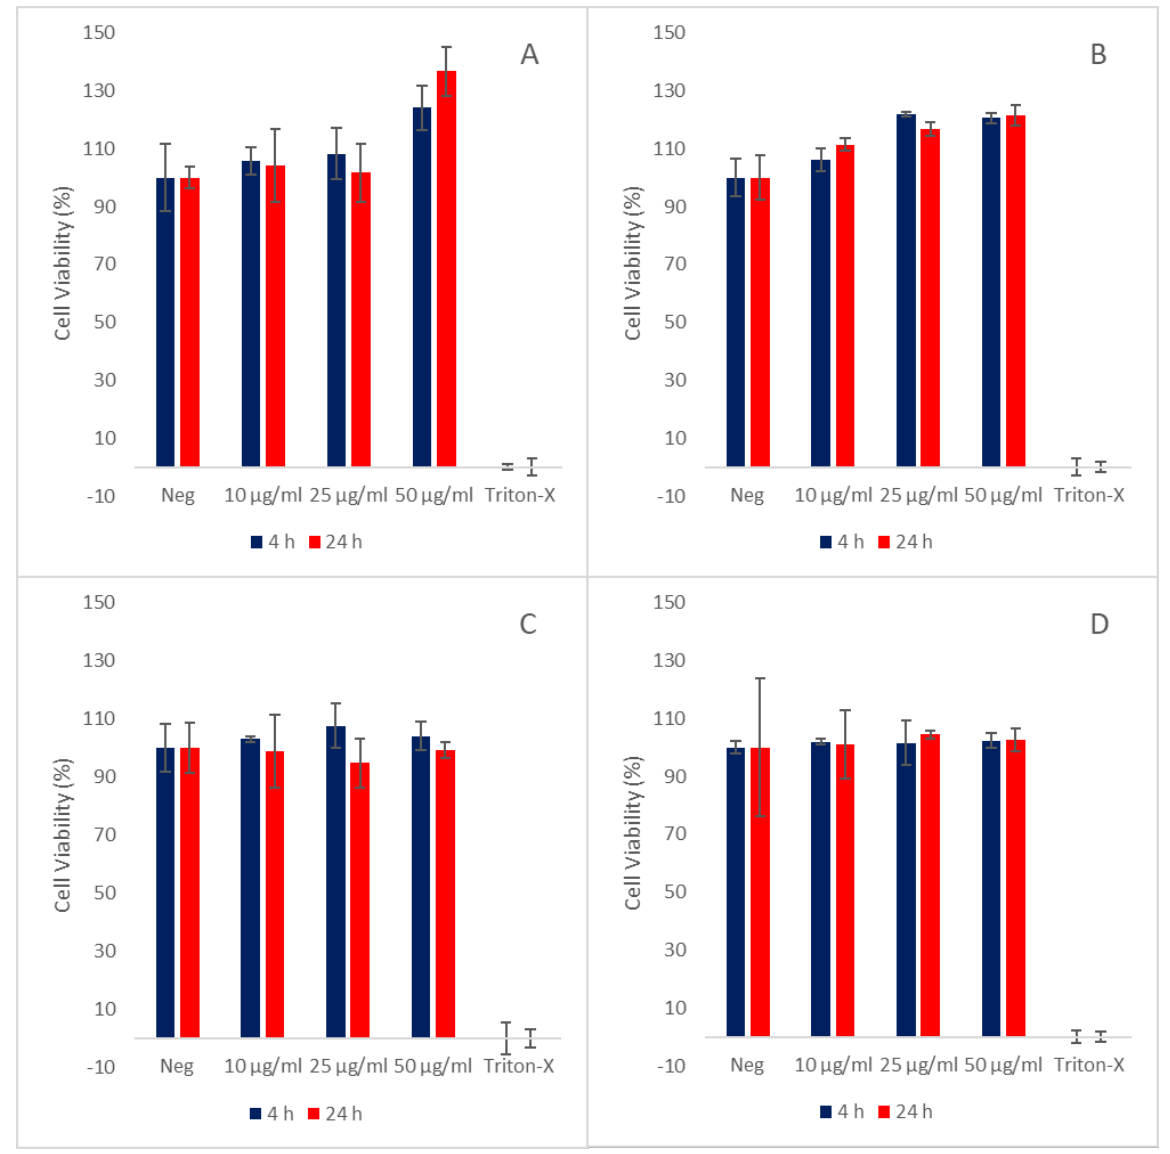
Figure 2. The GL261 cell viability assessed by MTS assay performed at 4 and 24 h incubation with different liposomal formulations. Data given as mean ± SD of % viability (n = 3). ( A ): pH-Lip, ( B ): pH-Lip750, ( C ): pH-Lip2000, ( D ): Lip. DMEM with 10% FBS used as negative control (Neg) and 0.1% Triton-X as positive control. pH-Lip: pH-responsive liposomes without PEG, pH-Lip–PEG750: pH-responsive with DSPE-PEG750, pH-Lip–PEG2000: pH-responsive with DSPE-PEG2000, Lip: non-pH-responsive, non-PEGylated liposomes.